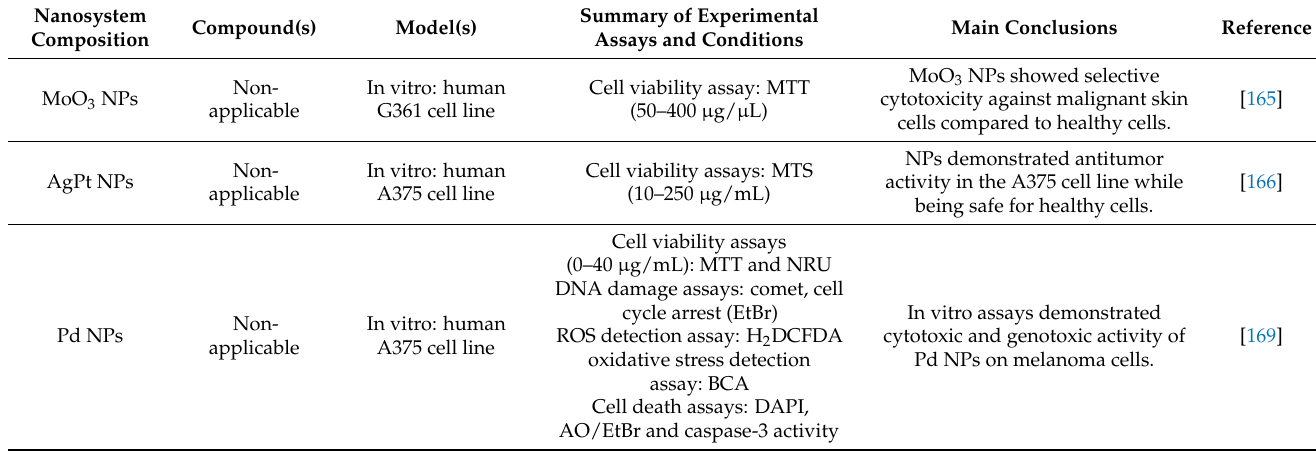
Table 5. In vitro and in vivo assessment of the therapeutic potential of different metallic-based nanoparticles in melanoma